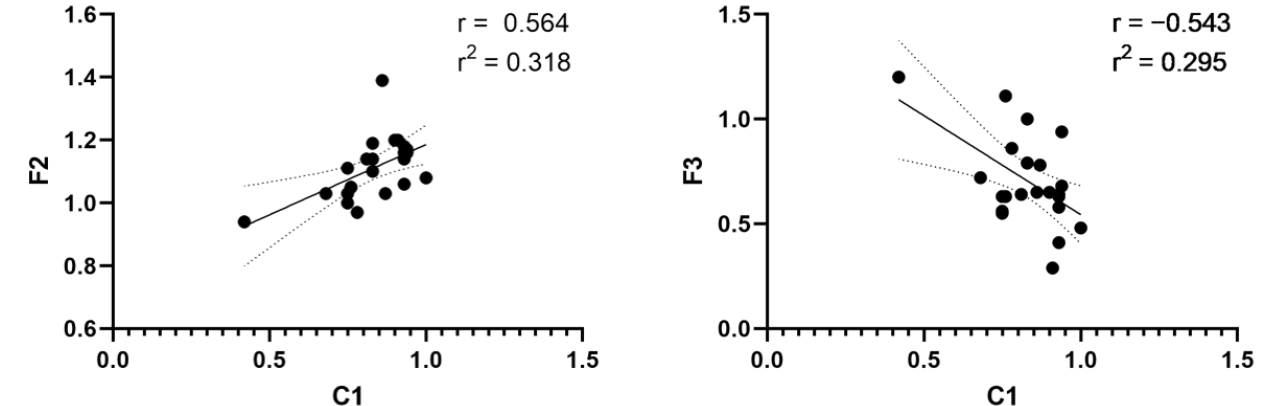
Figure 5. Correlation and linear regression test. ( left ) Alveolar height (C1)—lip height (F2) demon- strates a statistically significant positive correlation. ( right ) Alveolar height (C1)—dry vermilion thickness (F3) demonstrates a statistically significant negative correlation.